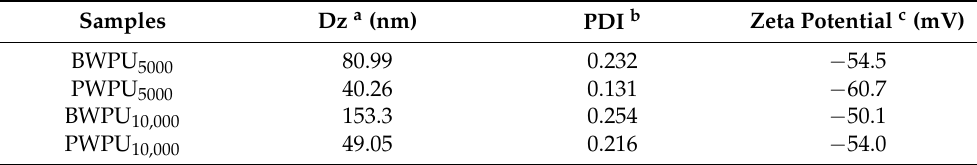
Table 2. Physicochemical parameters of PWPU and BWPU emulsions (0.5 mg/mL).